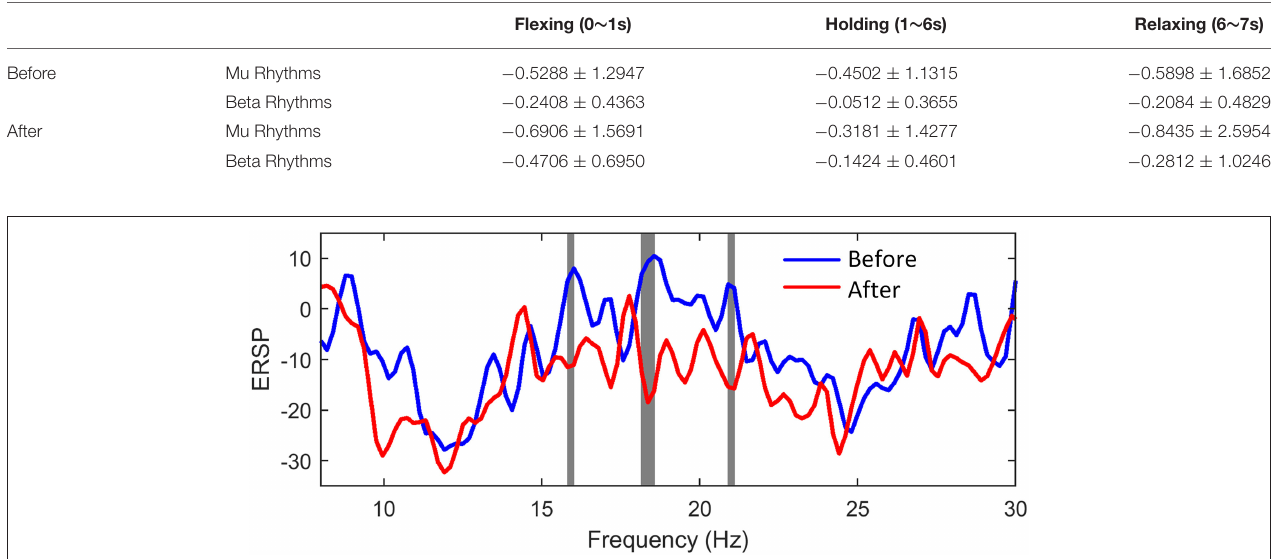
TABLE 3 | Average of ERSP.